Question: Provide a one-line summary of what is displayed.
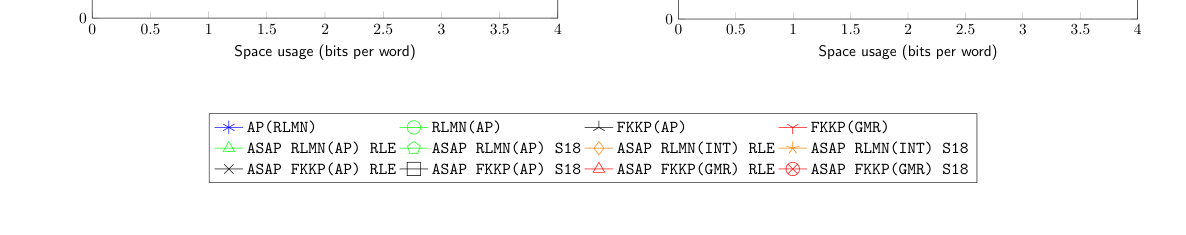
Answer: Space/time trade-off for count queries on the Burrows-Wheeler Transform (see Algorithm 2) of different large-alphabet texts, for the alphabet partition alternative A4 using patterns of length 4 and 16.